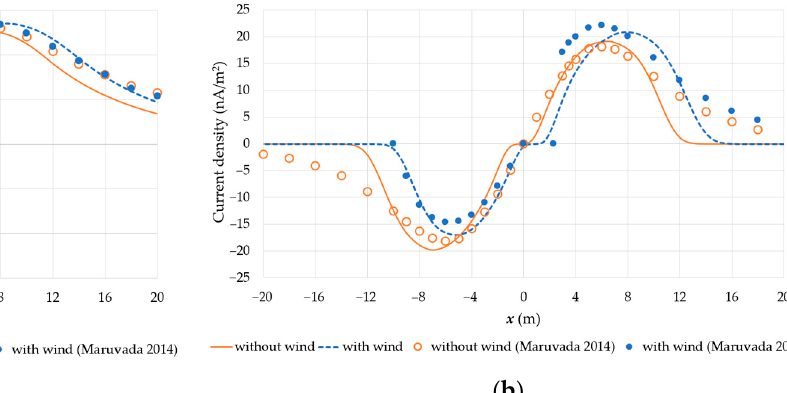
Figure 7. Electric field and ion current density at the ground level of the ±250 kV configuration: ( a ) electric field E g ; ( b ) ion current density J g .